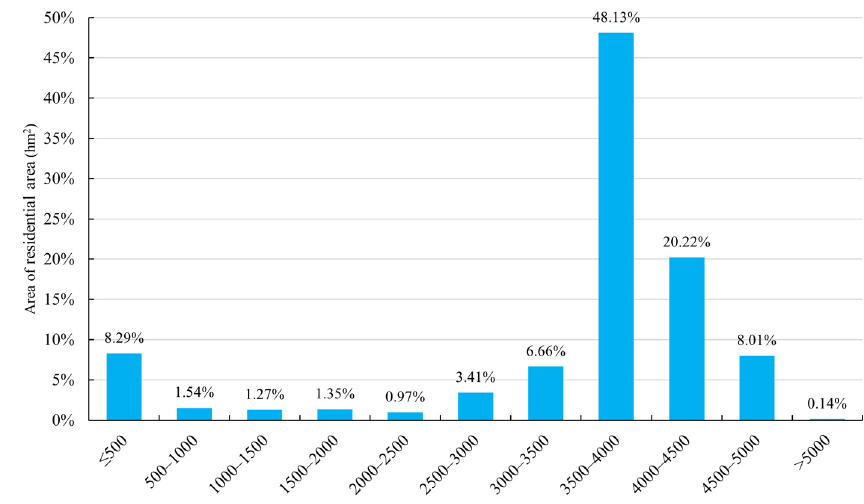
Figure 10. Area statistics of residential areas at different altitudes.